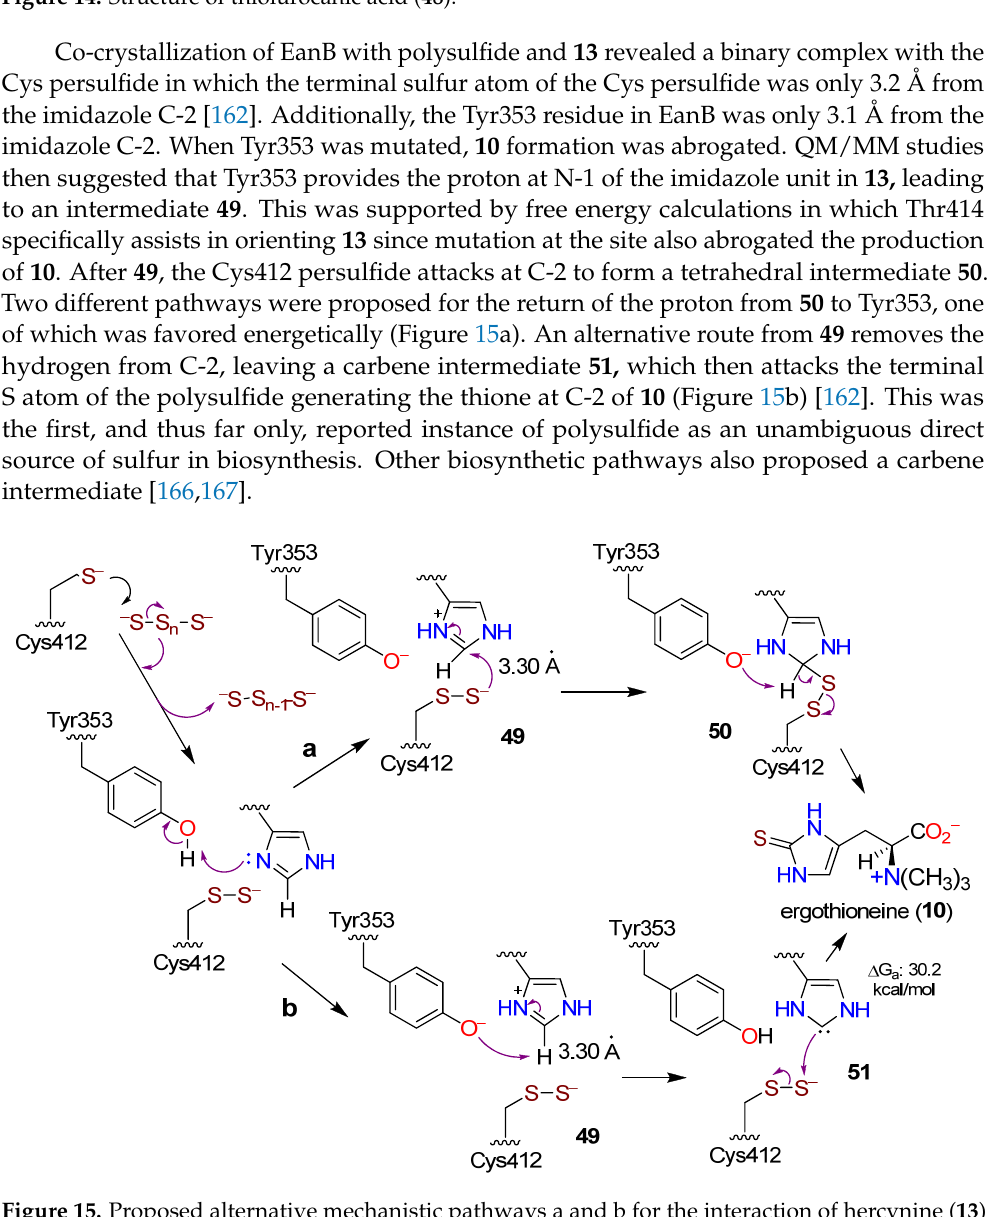
Figure 16. Structures of selenoneine ( 12 ) and selenocysteine ( 52 ).